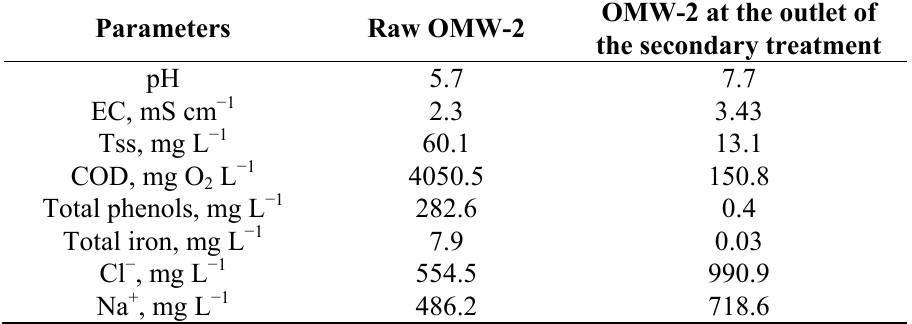
Table 2. Olive mill wastewater (OMW-2) characterization at the outlet of each secondary treatment stage.